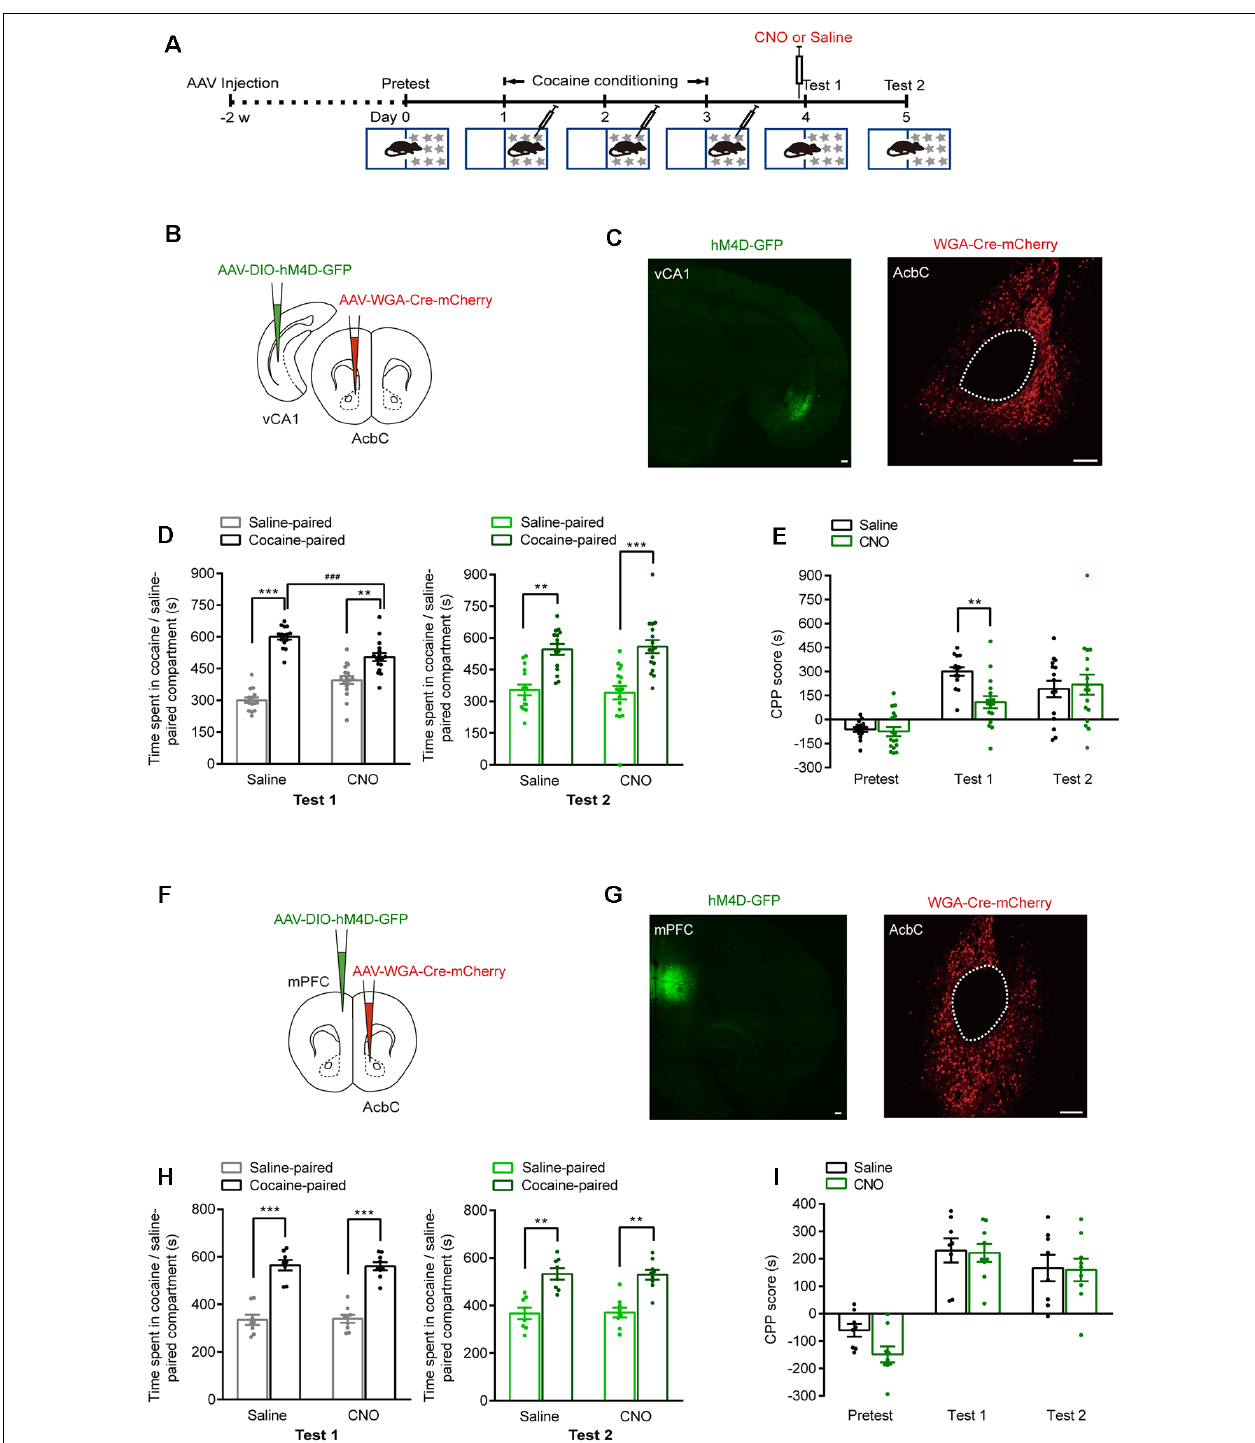
FIGURE 5 | Chemogenetic inhibition of AcbC-projecting vCA1 neurons suppressed the retrieval of cocaine-CPP memory. (A) Behavioral schedule. AAV-hSyn-WGA-Cre-mCherry and AAV-EF1 α -DIO-hM4D-GFP were injected in the indicated brain regions 2 weeks before CPP training. Saline or CNO (1 mg/kg, i.p.) was injected 30 min before test 1. (B,F) AAV injection strategy. (C,G) Representative images of hM4D-GFP and WGA-Cre-mCherry fluorescence in brain regions as indicated. Scale bar: 100 µ m. (D,H) Bar graphs representing the time spent in the cocaine-paired and saline-paired compartment of saline- and CNO-treated groups in test 1 and test 2 sessions. ** P < 0.01, *** P < 0.001 vs. saline-paired compartment, ### P < 0.001 vs. saline group. (E,I) Bar graphs showing the CPP scores of saline- and CNO-treated groups. ** P < 0.01 vs. saline group (vCA1–AcbC: saline n = 15, CNO n = 17; mPFC–AcbC: saline n = 8, CNO n = 9).